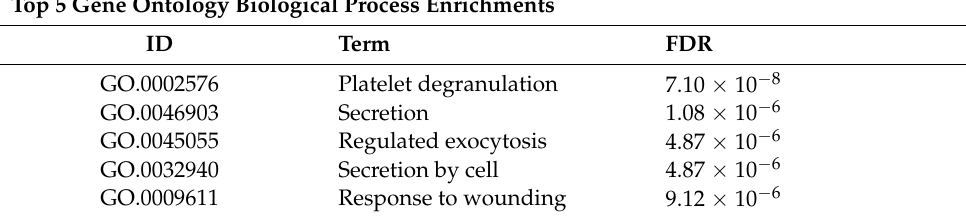
Table 3. Top 5 Gene Ontology biological process enrichments for visceral versus subcutaneous adipose tissue differential expression network. FDR, false discovery rate.